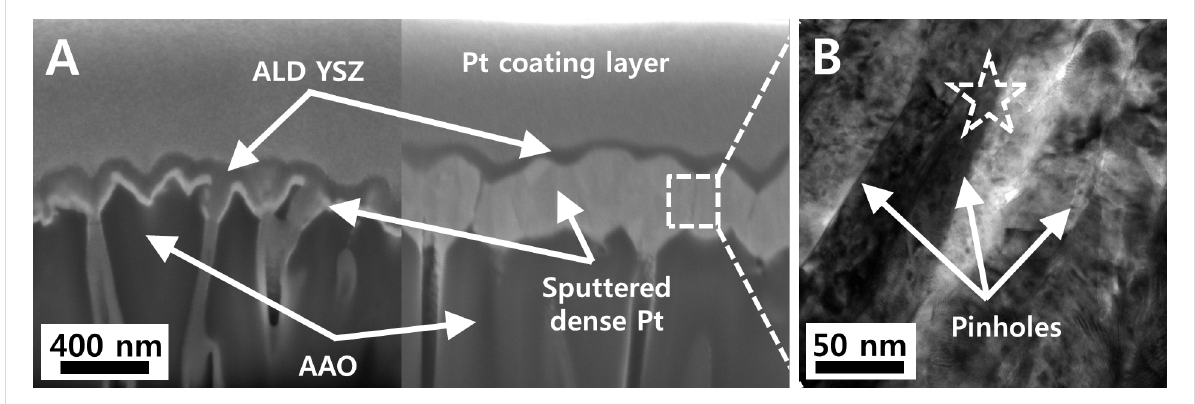
Figure 2: (A) Focused ion beam-prepared field emission scanning electron microscopy (FE-SEM) cross-sectional images for 50 nm-thick ALD YSZ films deposited on 80 nm pore AAO supported 40 (left side) and 320 (right side) nm-thick BECs; (B) transmission electron microscopic image for 80 nm pore AAO supported 320 nm-thick